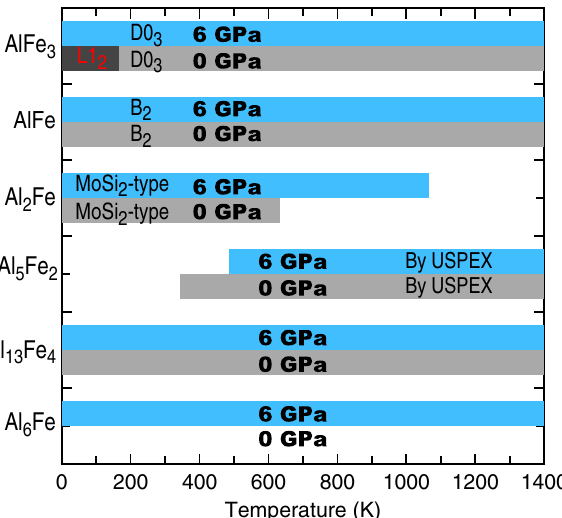
Figure 5. Phase stability (on the convex hull) of Al–Fe IMCs under external pressures of 0 and 6 GPa as a function of temperature (shown in the shaded regions) based on the present DFT calculations using Eq. (3). The predicted L1 2 -AlFe 3 presented at low temperatures is due to the employed X-C functional of GGA, see discussion in main